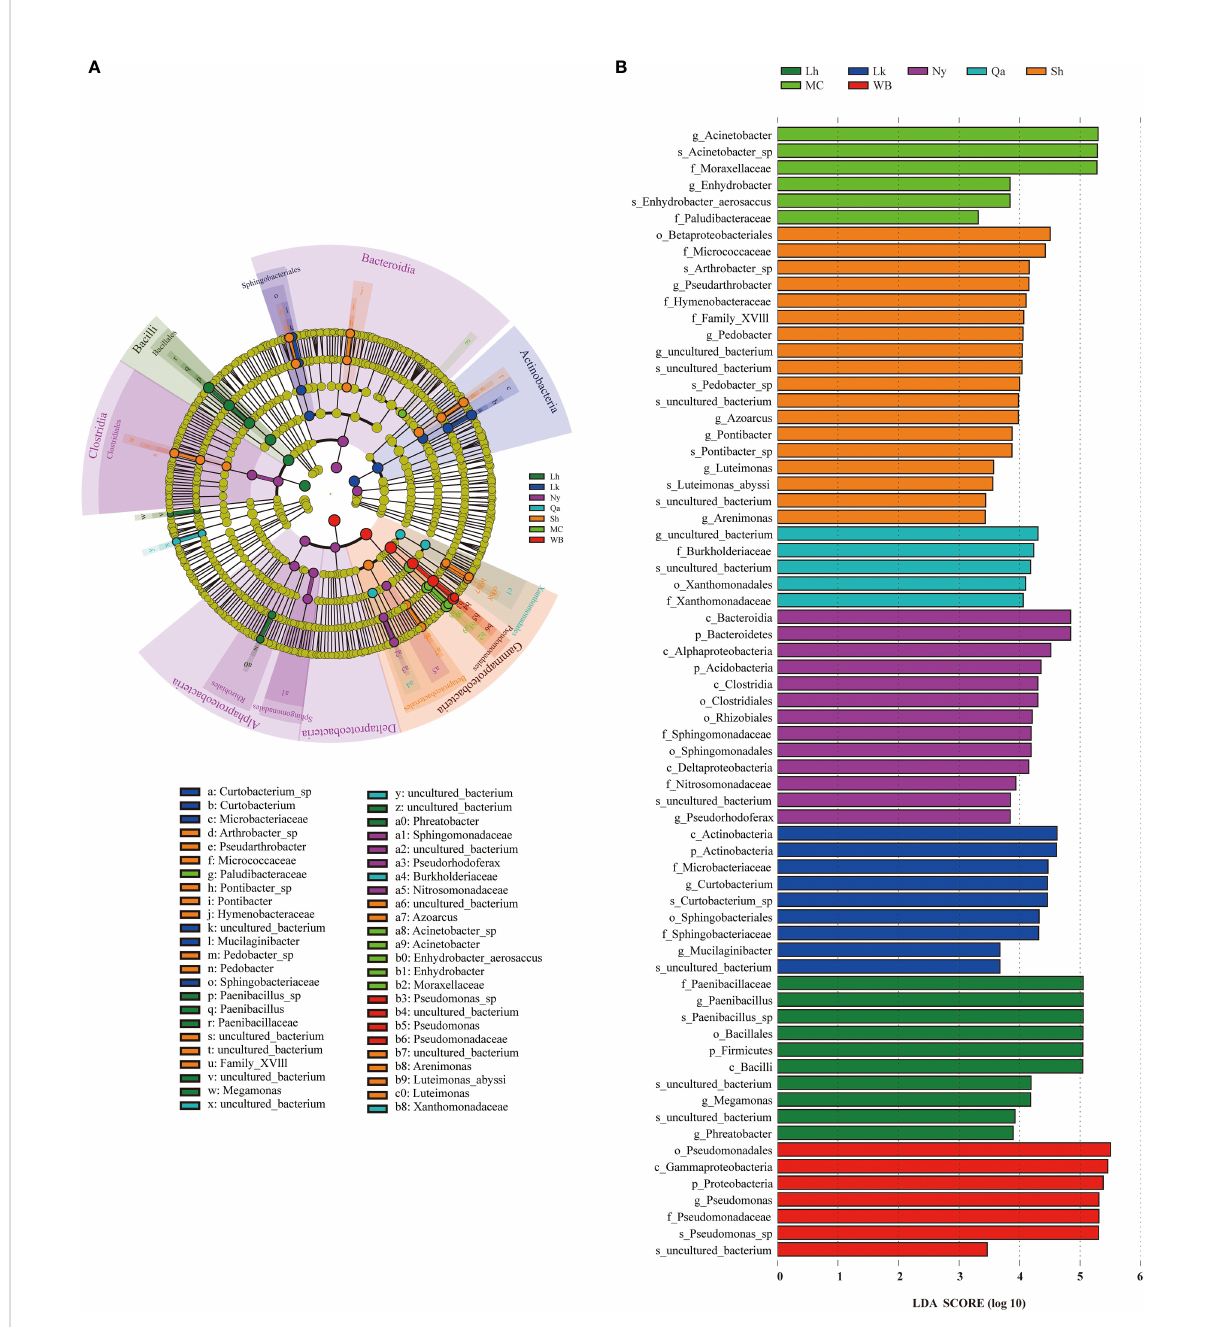
FIGURE 5 Using the Linear discriminant analysis Effect Size (LEfSe) method, the abundance of qingke seeds of different types of different bacterial taxa was revealed. (A) Clade diagram representation of the phylogenetic relationships of taxa with differences in abundance among qingke seeds from different sources. Nodes from inside to outside represent phyla, classes, orders, families, genera and species. (B) LEfSe analysis of endophytic bacteria in qingke seeds from different sources ( P < 0.05, log LDA score threshold ≥